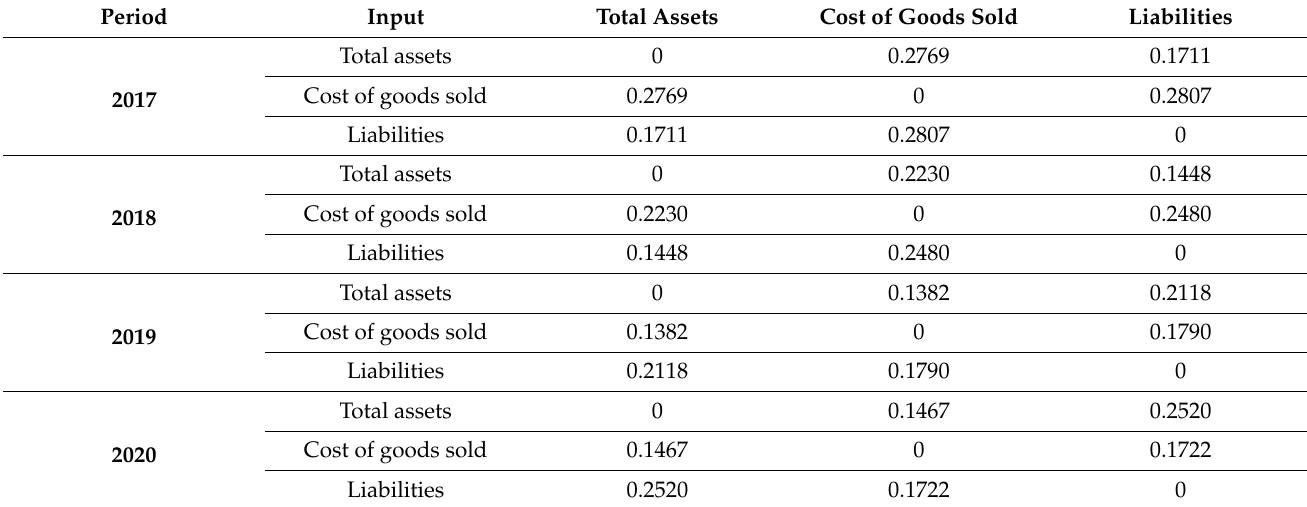
Table 12. Diversity matrix in EBM model (2017–2020).